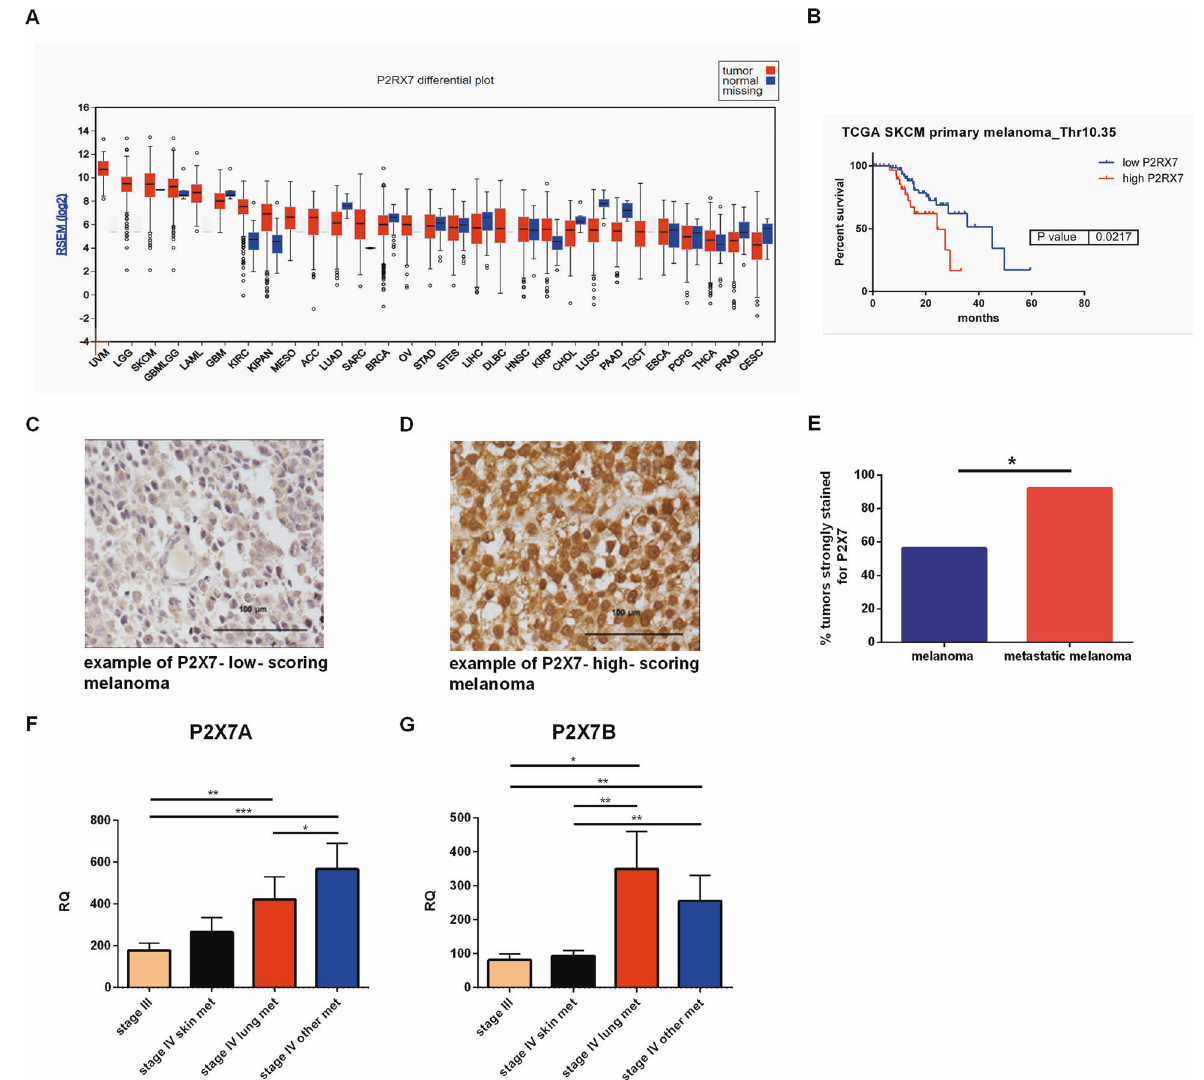
Fig. 1 P2X7R over-expression associates with reduced overall survival and metastasis in melanoma patients. A expression of P2X7R in tumor and normal samples from TCGA database. Normalized expression of P2X7R, detected using RNA sequencing, was obtained from Firebrowse database. Tumor types were ordered according to log2 P2X7R expression. B overall survival of melanoma patients with low or high P2X7R expression (threshold 10,35). C representative image of weak immunohistochemical staining for P2X7R of a human melanoma sample. D representative image of strong immunohistochemical staining for P2X7R of a human metastatic melanoma specimen. E Percentage of metastatic (red, N = 14) and non-metastatic melanoma (blue, N = 25) samples with strong positivity for P2X7R p = 0.0283 exact Fishers ’ test. F and G mRNA level of P2X7RA and P2X7RB evaluated in 77 cDNAs from melanoma patients subdivided in stage III ( N = 27), stage IV with skin metastasis ( N = 15), stage IV with lung metastasis ( N = 10), and stage IV with metastasis in other distant organs ( N = 14). * p < 0.05, ** p < 0.01, *** p < 0.001 by Student ’ s t